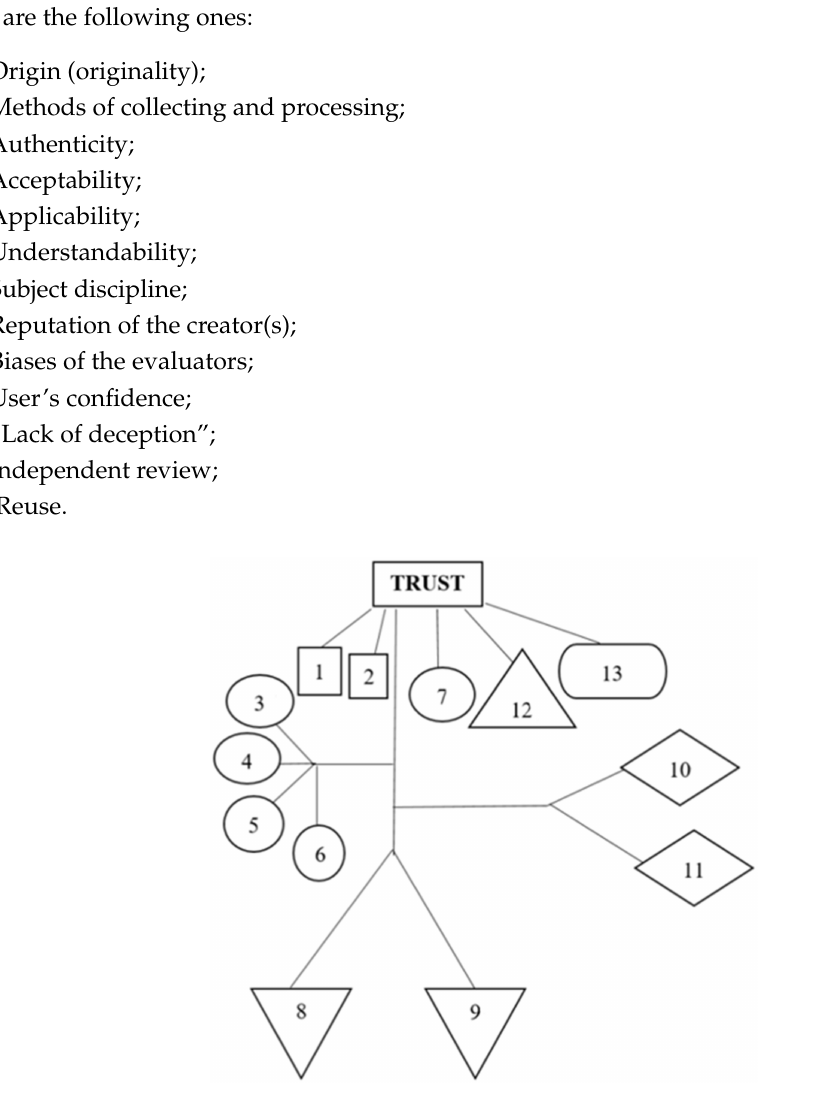
Figure 1. The relationships between elements of